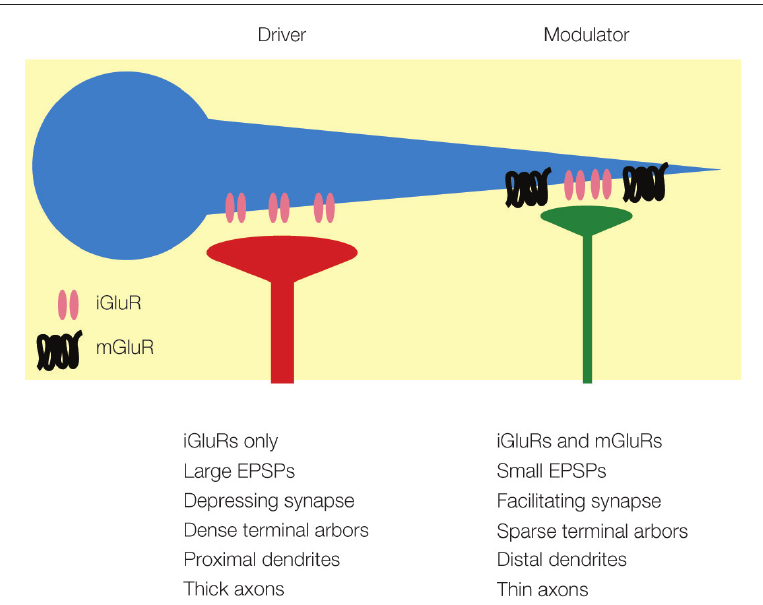
Figure 1 | Summary of anatomical and physiological properties of driver (red) and modulator (green) synapses onto a neuron (blue) (adapted from Lee and Sherman, 2009b).